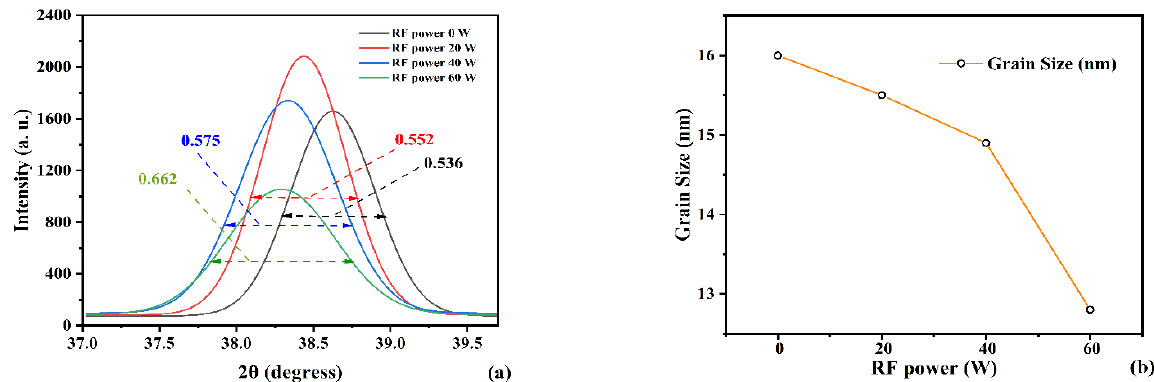
Figure 6. ( a ) FWHMs of the (110) crystal plane diffraction peak and ( b ) grain sizes of the Nb films deposited under different RF bias powers.